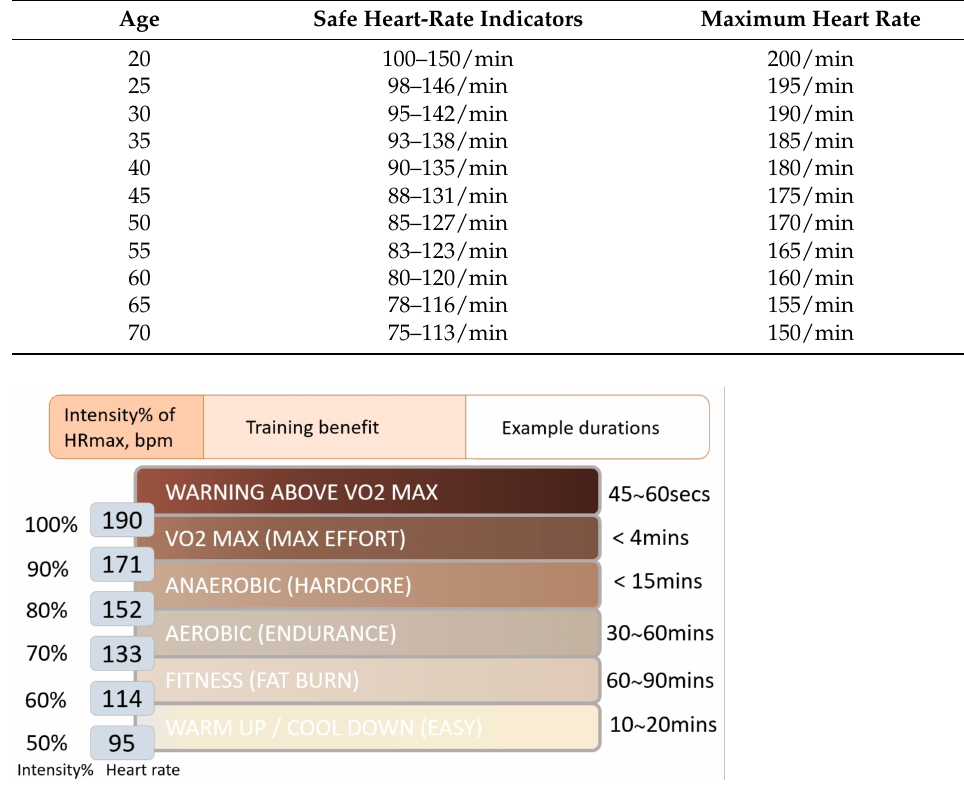
Figure 2. Effect of training on heart rate